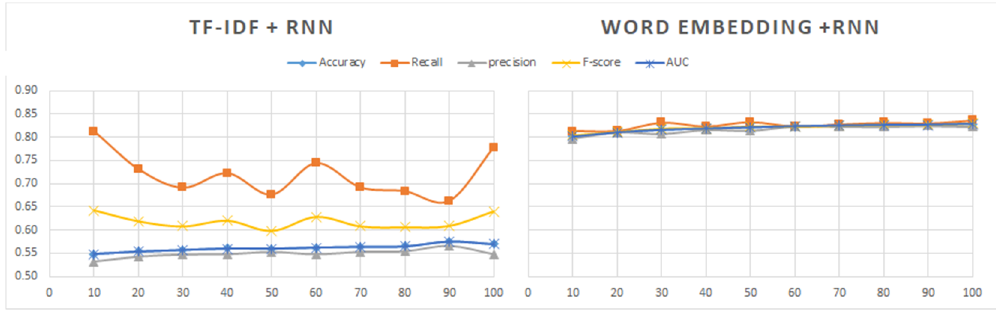
Figure 15. Comparison of all measures for RNN with TF-IDF (left) and word embedding (right).